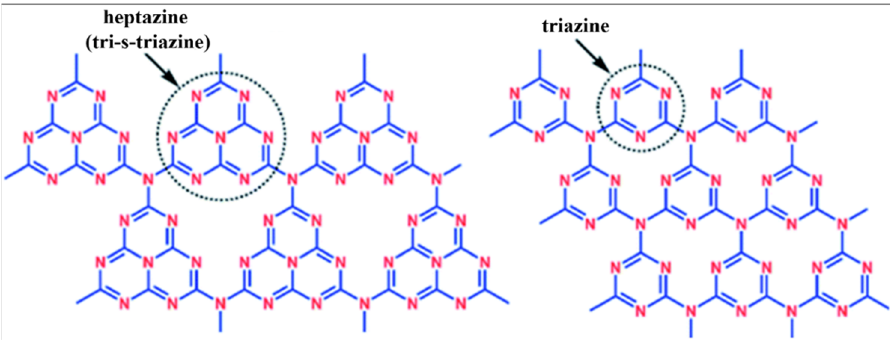
Figure 1. Two fundamental structural units of g-C 3 N 4 . Reprinted with permission from reference [36], Copyright 2018, Royal Society of Chemistry.